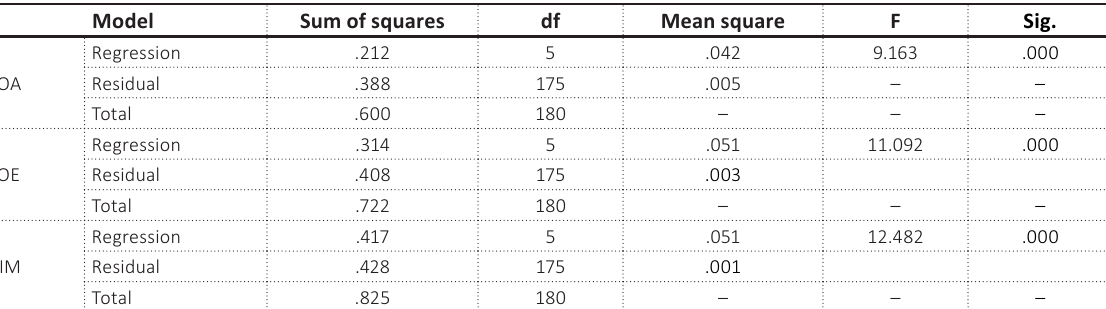
Source: Analytical data from SPSS